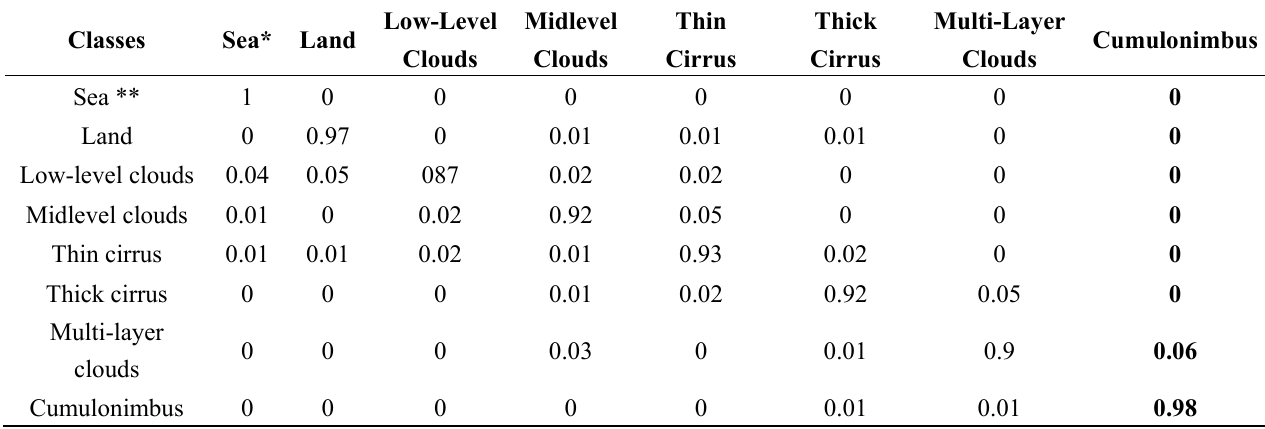
Table 2. Confusion matrix of the cloud classification using the artificial neural network (ANN) classifier [22].